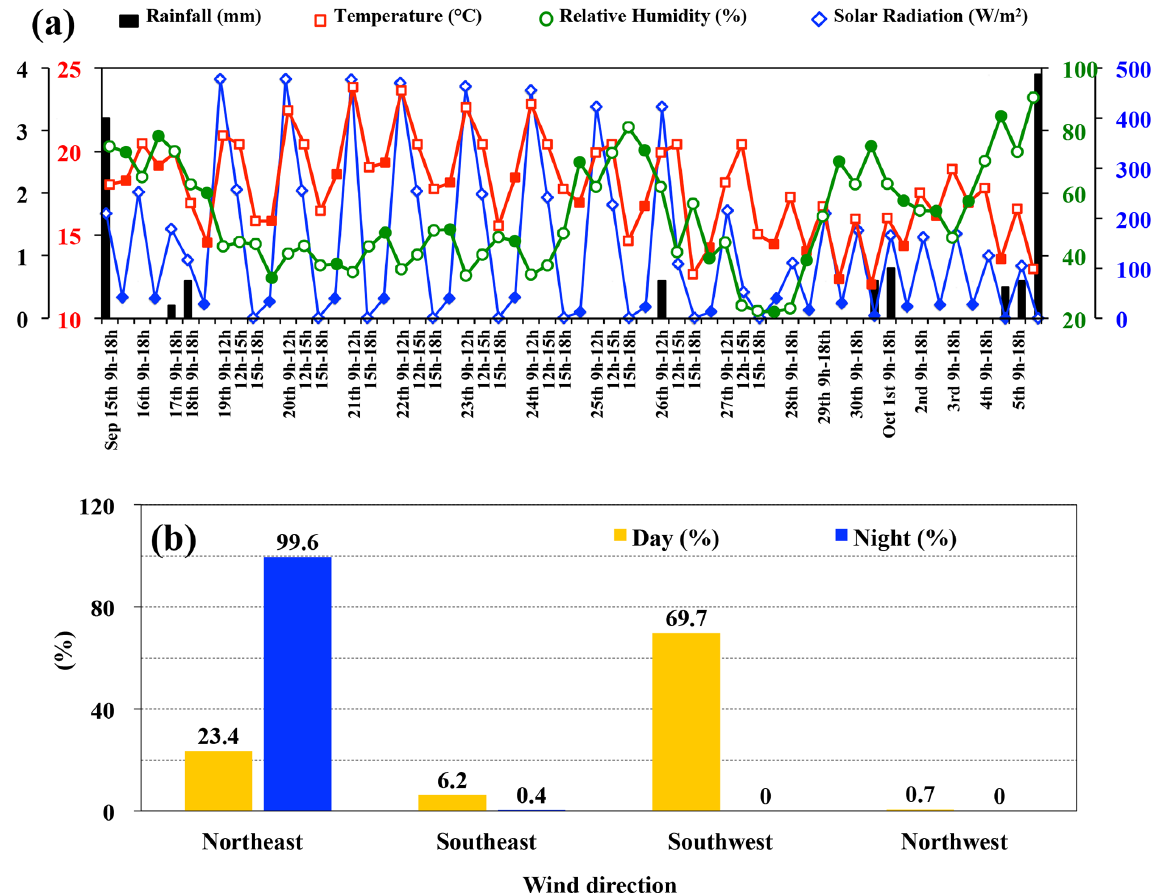
Figure 2. (a) The meteorological parameters at Mangshan during sampling periods. (b) Fractions of local wind directions at the Mangshan site, north of Beijing,